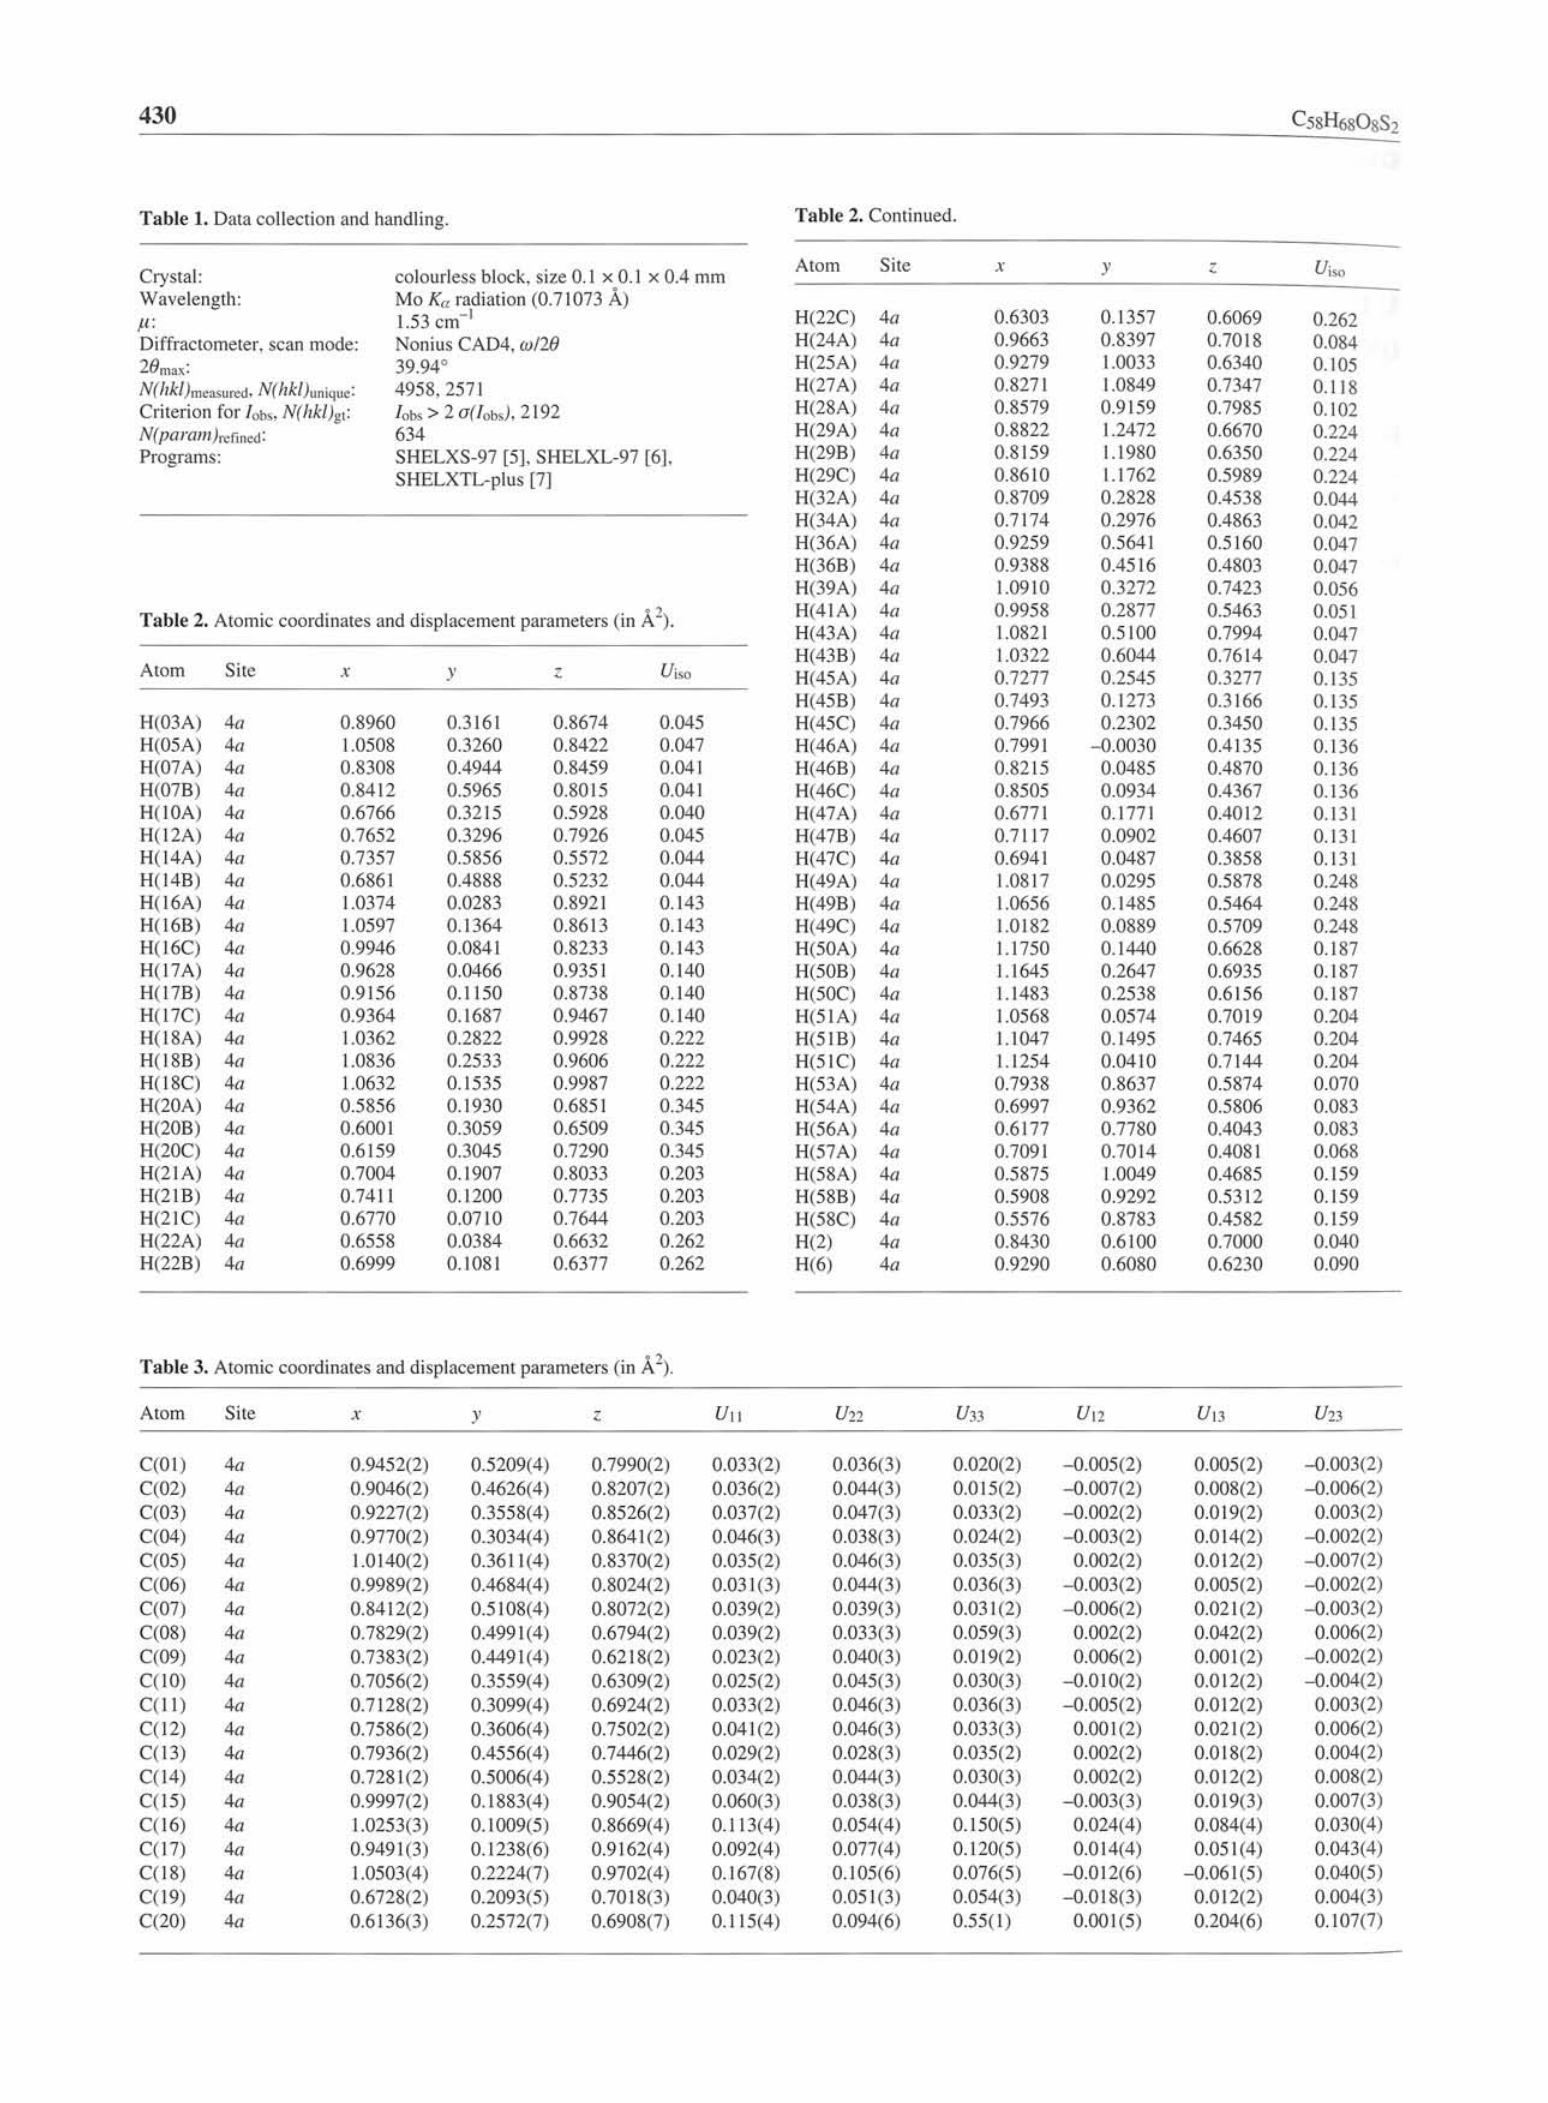
Table 3. Atomic coordinates and displacement parameters (in Â 2